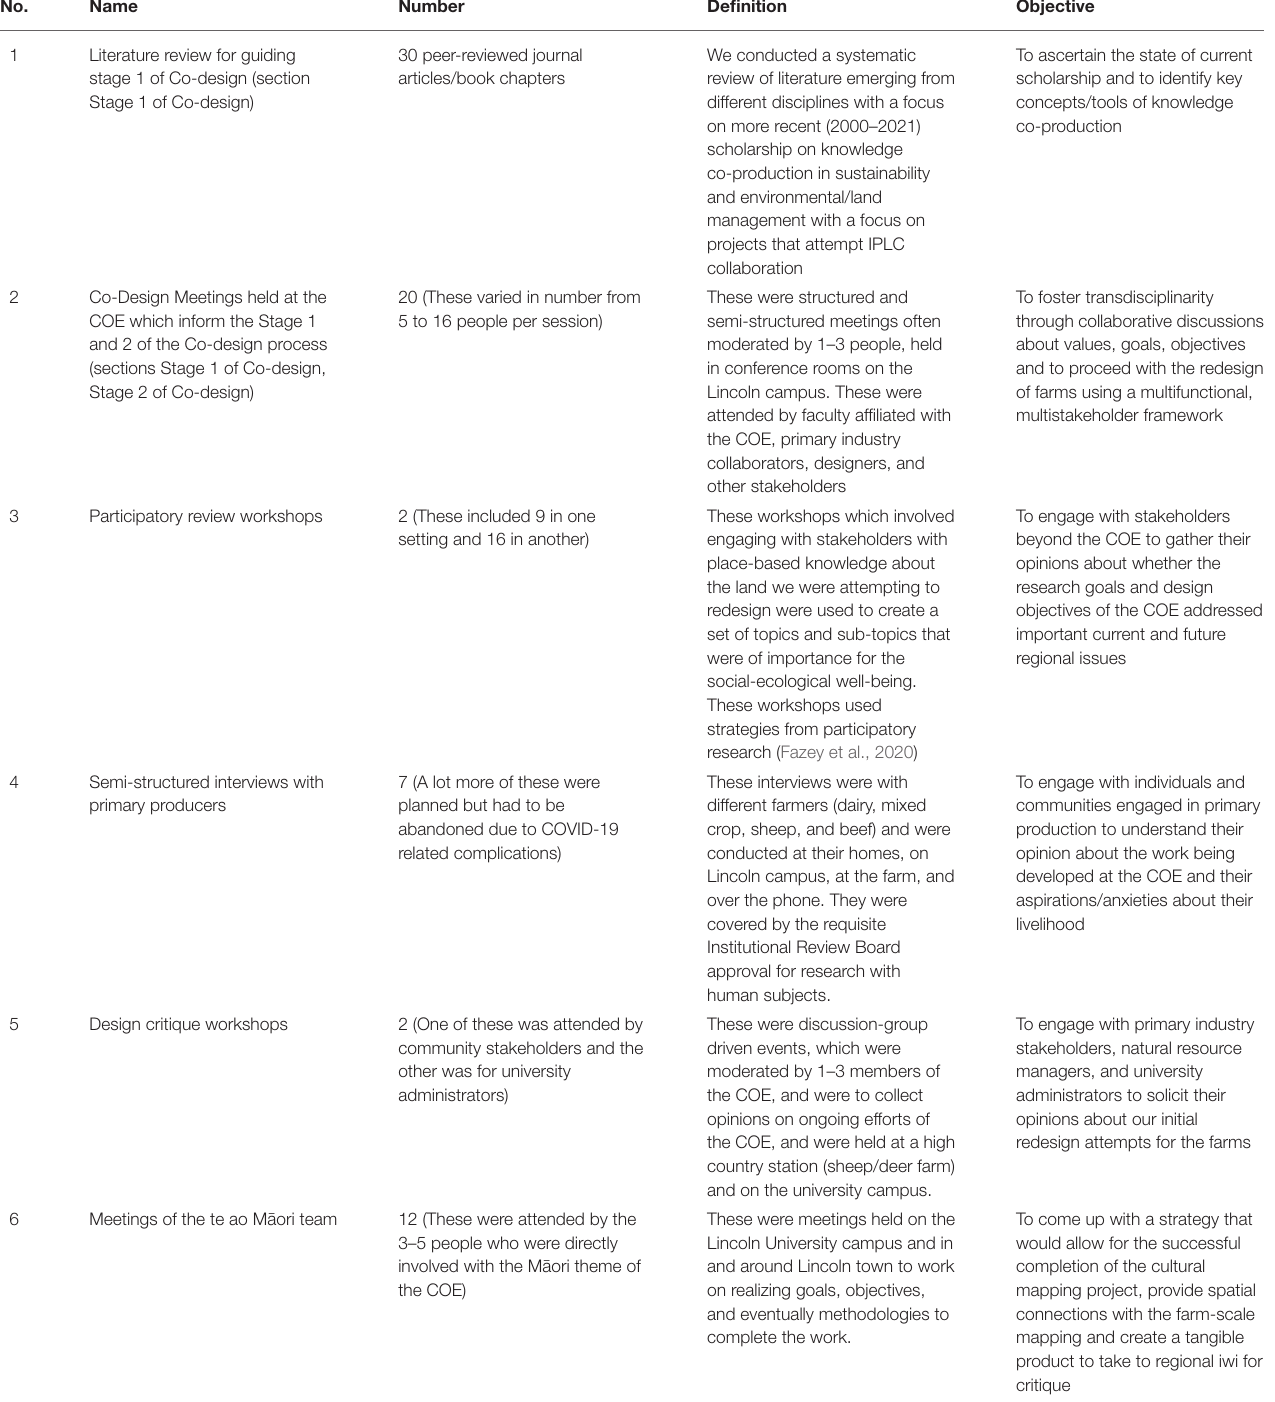
TABLE 2 | Mixed-methods data analyzed for this paper.